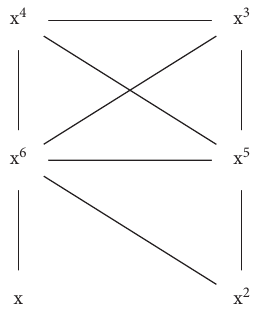
Figure 1: S 6 M monogenic semigroup graph.